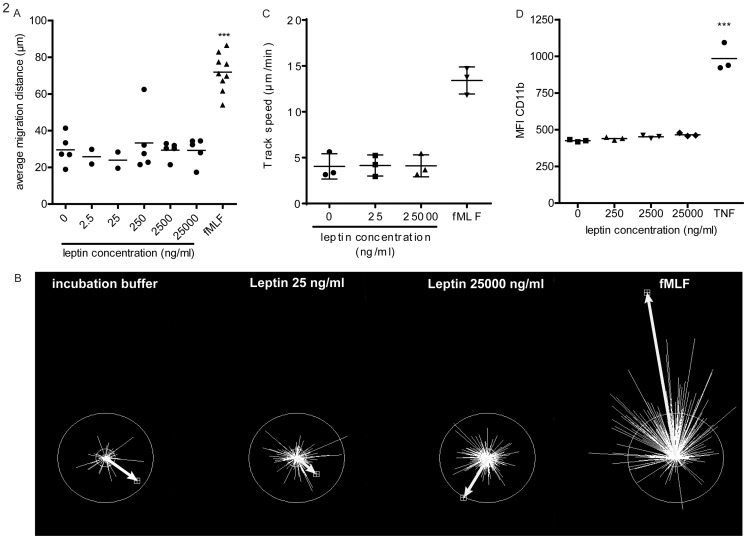
Effects of leptin on neutrophil chemotaxis and CD11b expression.(A) Isolated neutrophils were placed in a boyden chamber on top of a filter with different concentrations leptin or positive control fMLF (10−8 M) below the filter. Cells were allowed to migrate for 45 min at 37°C, afterwards filters were stained and average migration distance was calculated. Mean ± SEM, n = 2–9. Statistics done using one-way ANOVA with Bonferroni posttest comparing leptin stimulated to control (0 ng/ml leptin), ***P = <0.001. (B) Neutrophils chemotaxis in fibrin gel. Neutrophils were captured in a fibrin gel, chemotaxis towards leptin and positive control fMLF (10−8 M) in the upper compartment was recorded using a microscope system. Afterwards vector tracks of all the cells were centered and directionality was determined. Directionality is shown by the white arrow, and is significant when the arrow reaches outside the circle. (C) Chemokinesis in a fibrin gel. Again neutrophils were captured in a fibrin gel but for the chemokinesis experiments the leptin or positive control fMLF (10−8 M) was present throughout the gel. Migration in the gel was recorded using a microscope system and track speed was analyzed. (D) Neutrophils were isolated and incubated with different concentrations of leptin or TNF (100 U/ml) as positive control for four hours. Afterwards cells were stained for CD11b, and mean fluorescence intensity (MFI) was determined by flow cytometry. Data are expressed as mean ± SEM, n = 3. Statistics are done using one-way ANOVA with Bonferroni posttest comparing leptin stimulated to control (0 ng/ml leptin).